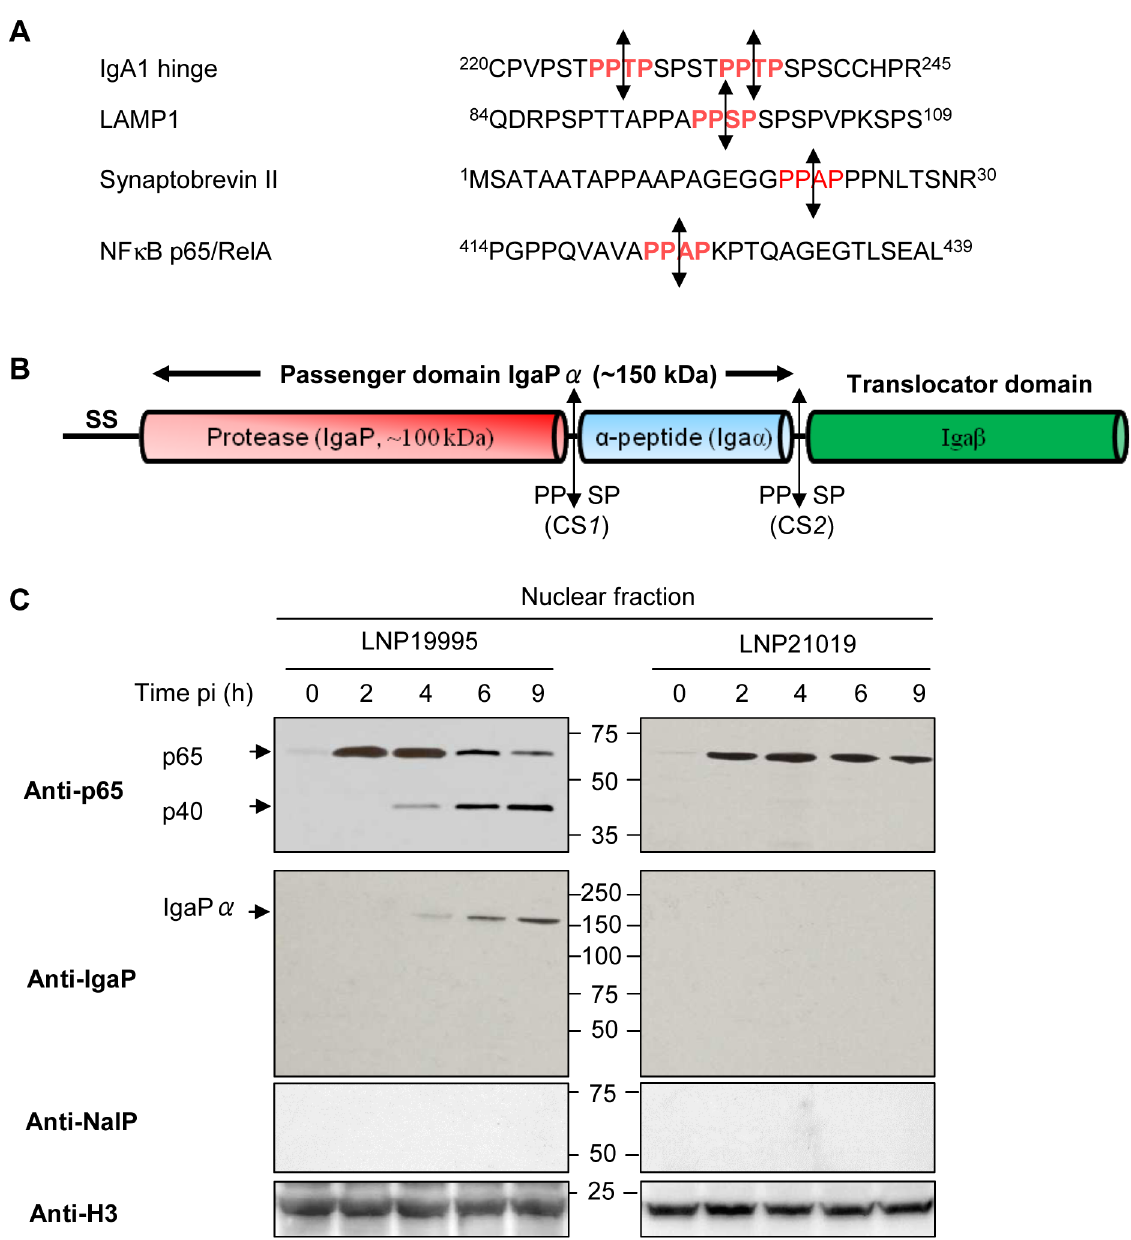
Fig 3. Cleavage of p65/RelA correlates with nuclear translocation of IgA protease. (A) Similarity between amino acid sequences of the hinge region of human IgA1, part of the N-terminal peptide of the human lysosome-associated membrane glycoprotein 1 LAMP1 (Accession N°: AAH06345), synaptobrevin II (Accession N°: AAF15551) targeted by neisseria IgA protease and part of the carboxy terminal peptide of the p65/RelA subunit of NF- κ B (Accession N°: CAA80524). The position of amino acid residues are indicated by superscript numbers delimiting each peptide sequence. Specific cleavage sites are indicated in red and the cleavage position is represented by double-headed arrows. (B) Schematic overview of the various domains and sub-domains of neisserial IgA protease. Autocatalyic cleavage sites CS1 and CS2 and their sequences are indicated by double-headed arrows. SS: signal sequence. (C) Nuclear fractions were prepared from Hec-1-B cells infected with LNP19995 or LNP21019 at indicated time points. Samples were resolved in SDS-PAGE and probed with anti-N-terminal p65 mAb or rabbit polyclonal serum specific to IgaP sub-domain or anti-NalP specific serum. Histone H3 was used as loading